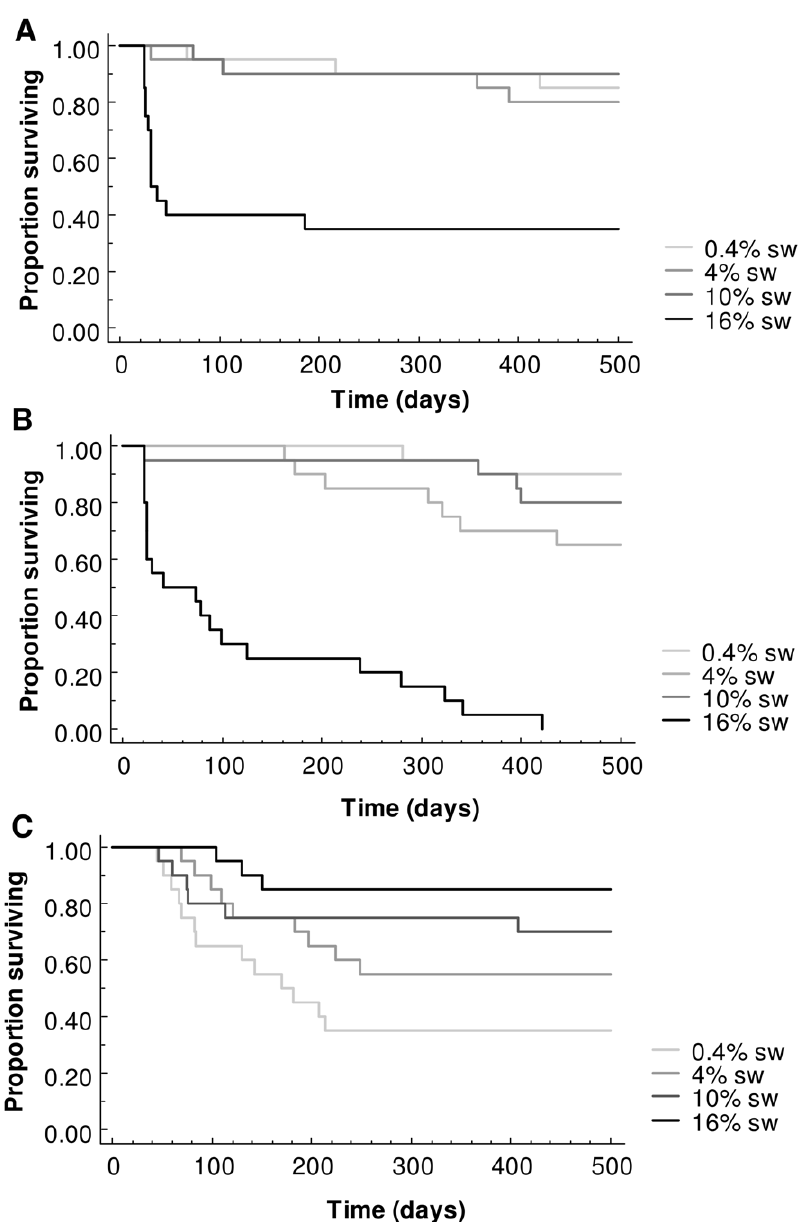
Figure 1. Proportion of tadpoles surviving from the effects of varying salinity over time for A Limnodynastes tasmaniensis B Neobatrachussudelli C Litoriaaurea.